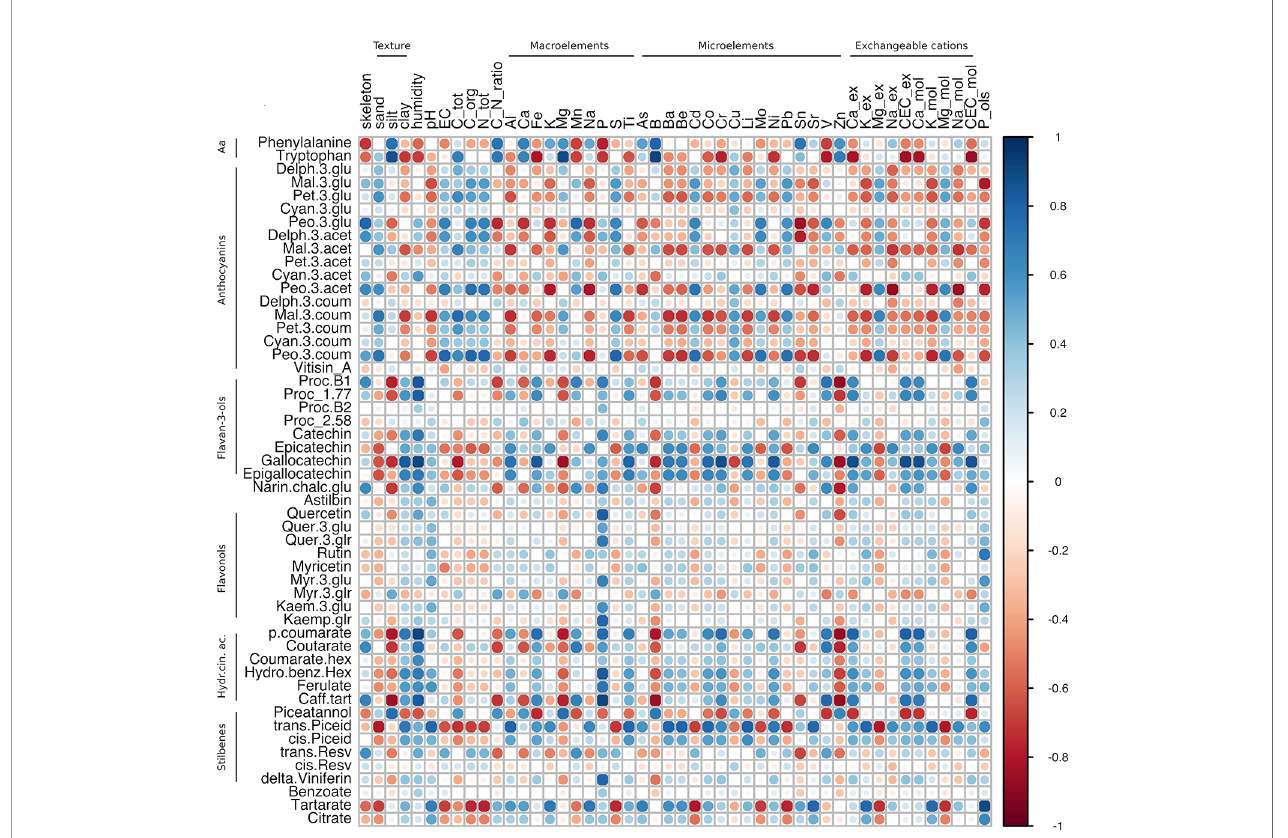
FIGURE 6 | Correlation analysis of grape skin secondary metabolites of cv. Corvina at harvest against the physico-chemical characteristics of the soil. The analysis was generated using Pearson's